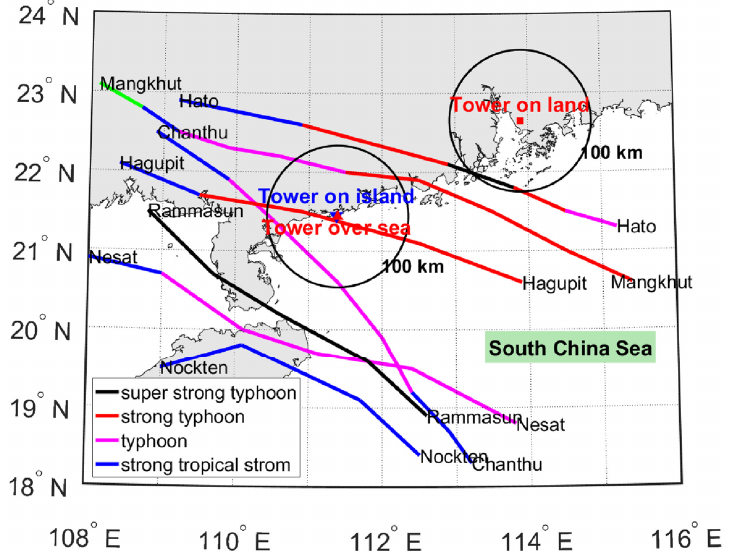
Figure 2. The tracks of the typhoons along with the locations of the three observation towers. The red upward-pointing triangle denotes the tower over sea corresponding to Figure 1a, the blue downward-pointing triangle denotes the tower on the island corresponding to Figure 1b, and the red square denotes the tower on land corresponding to Figure 1c. The distance between the tower over sea and the tower on the island is about 2 km, so their signs largely overlap each other. The black circles show the distance to the towers of 100 km. The different color lines mark the different typhoon categories. Super strong typhoon is larger than 51 m s − 1 , and then 41.4~51 m s − 1 , 32.7~41.4 m s − 1 , and 24.5~32.7 m s − 1 follow. The typhoon track and typhoon intensity data are from the website http://tcdata.typhoon.org.cn/ (accessed on 1 August 2022) [17].